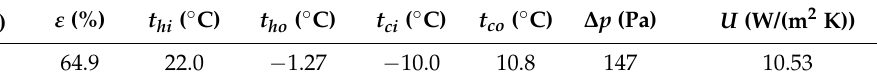
Table 5. Final HPHE working parameters for typical winter conditions.